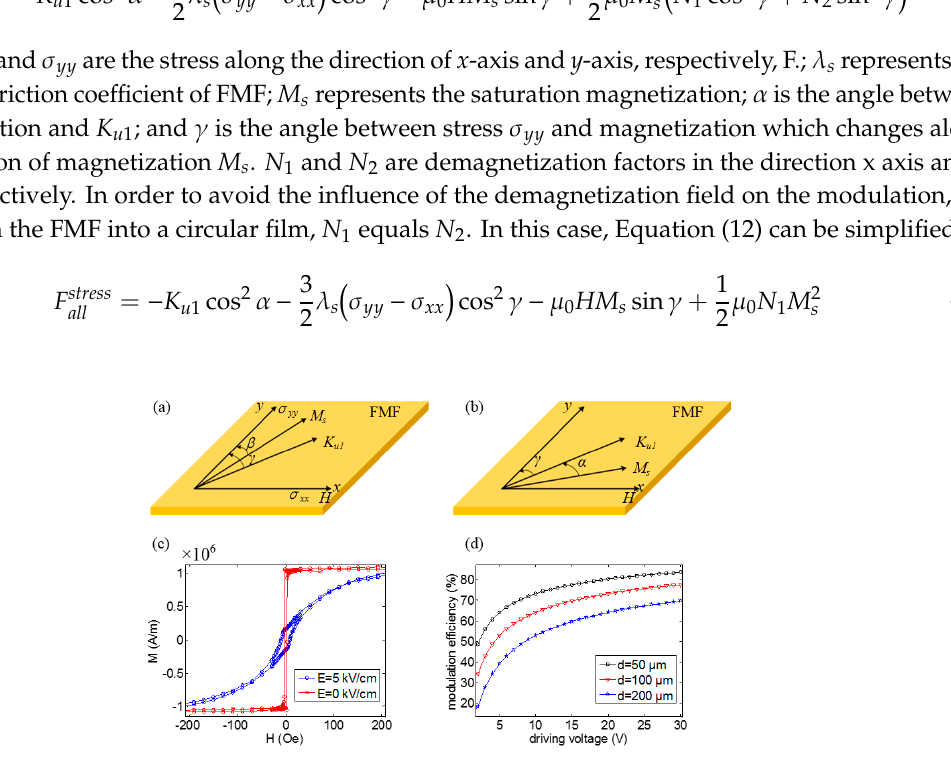
Figure 4. Illustration of magnetization direction under the impact of stress energy, magnetic crystal anisotropy energy, and Zeeman energy for ( a ) larger stress and ( b ) zero stress states, respectively.Thereinto, M s represents saturation magnetization. K u1 represents anisotropy. H represents external magnetic field. σ xx and σ yy are the stress along the direction of x -axis and y -axis respectively. ( c ) the M–H curves of FeSiBPC/PMN-PT under different electric fields; ( d ) modulation efficiency as a function of driving voltage for FeSiBPC/PMN-PT under different FE thickness.